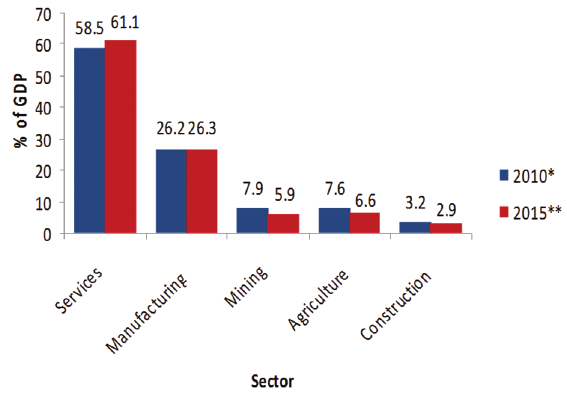
Figure 1 - National Economic Sectors as % of GDP contribution. Source: Economic Report 2009-2010 (DOS 2010); RMK 10 Report (EPU